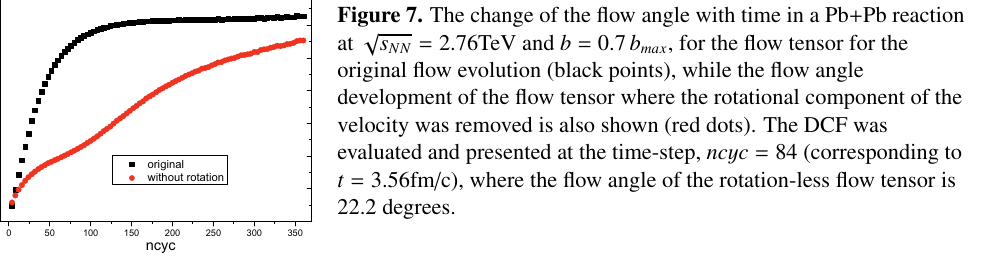
Figure 8. The Di ff erential Correlation Function (DCF) at average pion wavenumber, k = 5 / fm and fluid dynamical evolution time, t = 3 . 56fm / c, as a function of the functions of momentum di ff erence in the "out" direction q (in units of 1 / fm). The DCF is evaluated in a frame rotated in the reaction plane, in the c.m. system by angle α . The figure shows the result where the rotation component of the velocity field is removed. The DCF shows a minimum in its integrated value over q , for α = − 11 degrees. The shape of the DCF changes characteristically with the angle α . The "rotation-less" configuration is constructed in the fluid dynamical model, where the α = − 11 degree symmetry angle is found. Unfortunately this is not possible experimentally, so the direction of the symmetry axes should be found with other methods, like global flow analysis and / or azimuthal HBT